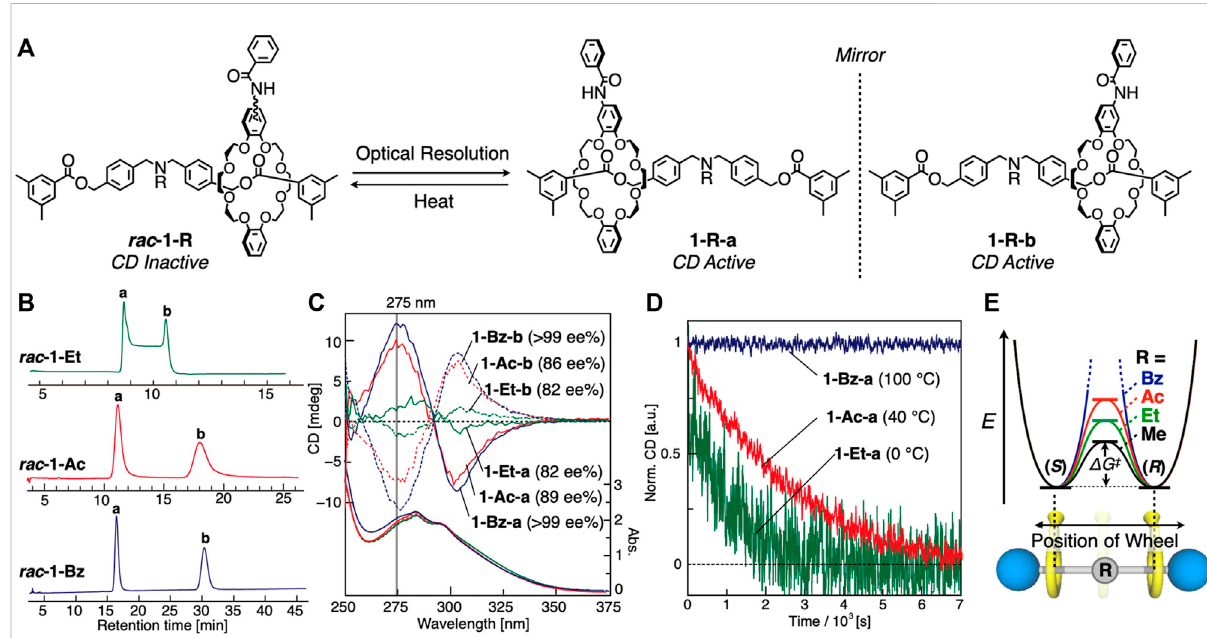
FIGURE 4 (A) Enantiomer separations of rac -1-R and racemization of 1-R-a and 1-R-b . (B) Chiral HPLC pro fi les (CHIRALPAK IA ® ) of rac -1-Et (at 333 K), rac -1-Ac (at 283 K), and rac -1-Bz (at 283 K). The determination of the rate constant of mechanostereoinversion by dynamic HPLC method was shown in Supplementary Figures S43 – S45 and Supplementary Table S2. Absolute structures of mechanically chiral rotaxanes could not be determined. (C) CDandUVspectraof 1-Et-a / b , 1-Ac-a / b and 1-Bz-a / b (0.1 mM,CHCl 3 ,263 K). (D) CDdecaypro fi lesof 1-Et-a (at273 K), 1-Ac- a (at 313 K) and 1-Bz-a (at 373 K) (0.1 mM, CHCl (E) Energy diagrams of 1-R 3 , 275 nm).